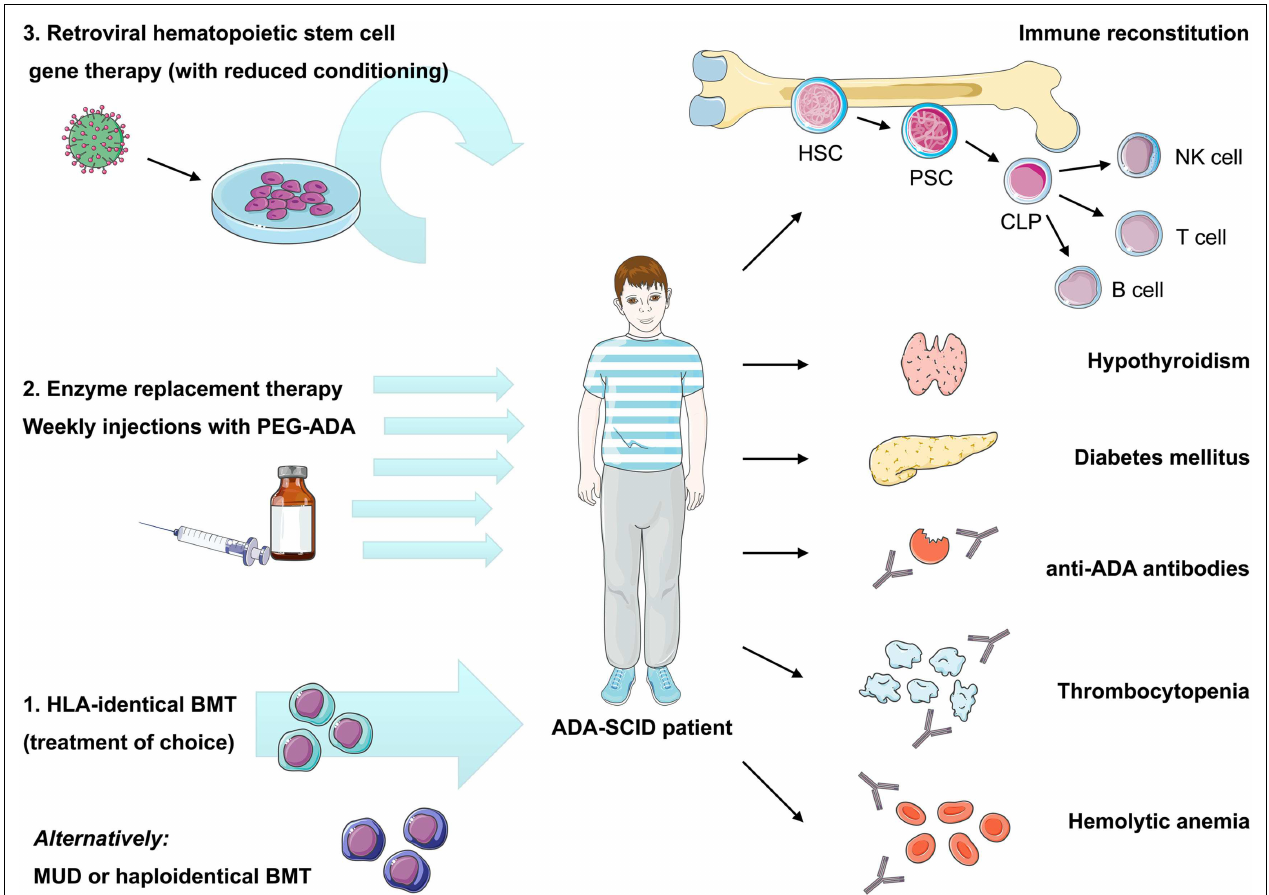
of human gene therapy. It is based on the reinfusion of autologous HSC transduced with a retroviral vector containing the ADA cDNA.Variable degrees of immune reconstitution can be achieved by these treatments, but onset of autoimmunity is of concern in post-treatment